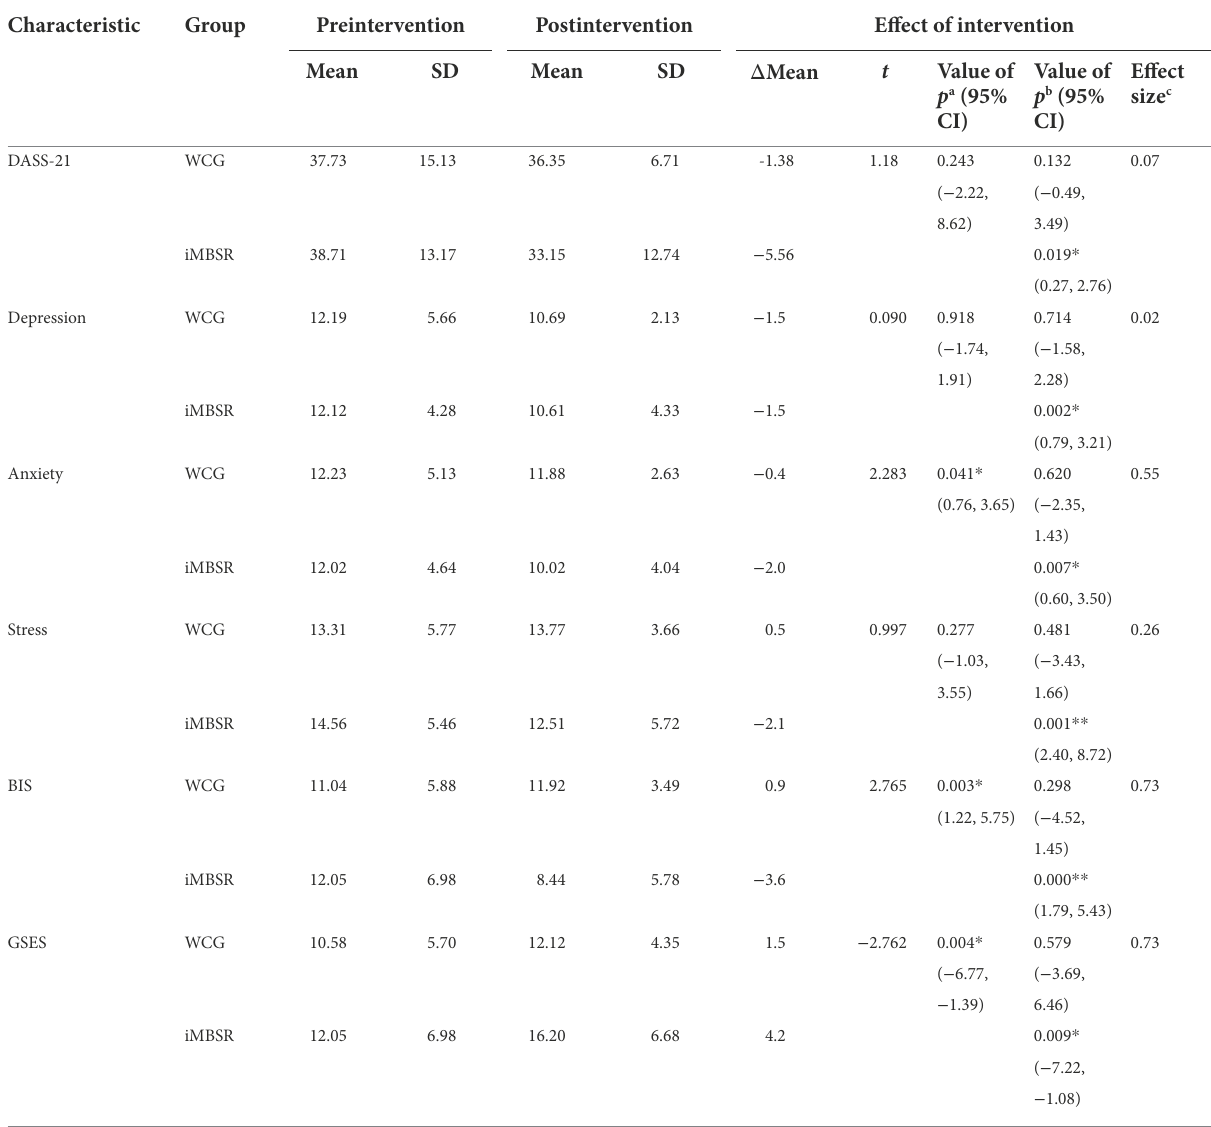
TABLE 4 The effect of pre and